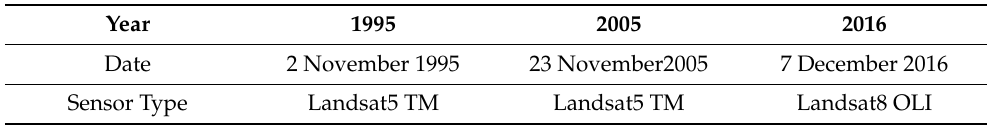
Table 1. Data information of Landsat TM